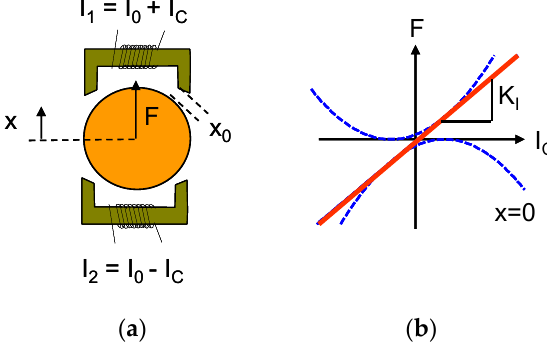
Figure 4. Conventional control strategy for AMB coils: constant bias current I 0 and control current I C . ( a ) Coil arrangement with bias current; ( b ) Linear current-force relationship.